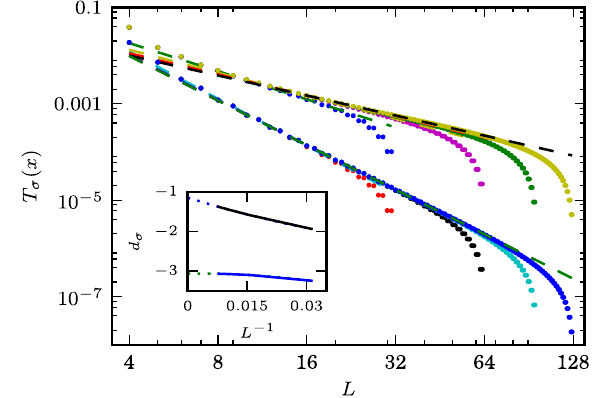
FIG. 2. Triplet pairing correlation function T σ ð x Þ for the couplings h ¼ 0 . 2 =t , J 1 =t ¼ 0 . 2 , J 2 =t ¼ 1 , and J 3 =t ¼ 0 . 5 , where t is the hopping in the lead. The upper set of lines shows the correlation function for spin- ↑ fermions, while the lower set of lines shows the data for spin- ↓ fermions. Dashed lines indicate fits to a power-law decay. The inset shows the exponents d ↑ (black line) and d ↓ (blue line) extracted from these